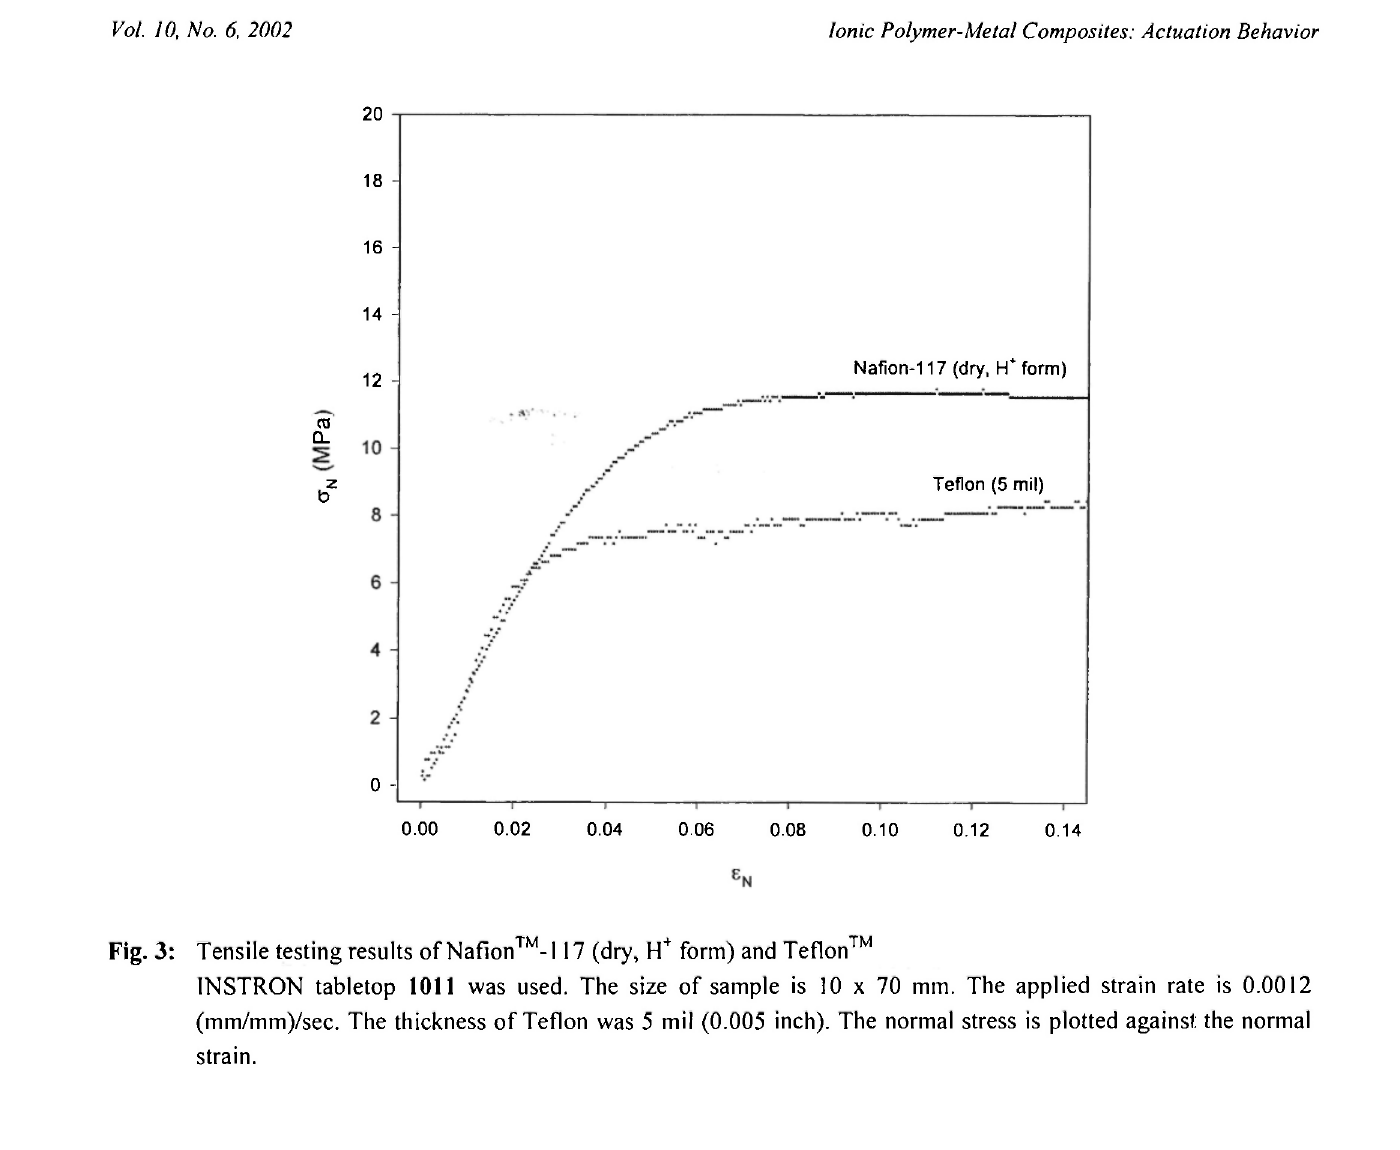
seen in Figure 4, the metallic platinum is not homogeneously formed across the membrane but concentrates predominantly at the interface. The platinum layer is buried deep within the membrane. The underlying principle of platinum metallization is